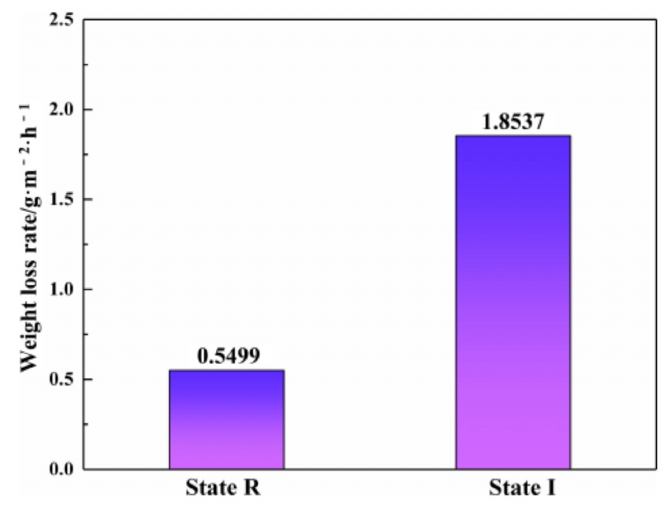
Figure 6. Weight losing rate of pitting corrosion in state R and state I. The negligible corrosion pits in state R are observed distributing spherically on the surface of samples (Figure 7a). As indicated by the red arrow in Figure 7c, the pits are open-type with an inner diameter less than the orifice diameter. Corrosion cracks emerge around the pits (yellow circle in Figure 7c), which indicates that the “bifurcation” expansion forms along a specific interface, for instance, grain boundaries or phase boundaries. In state I, the number of the corrosion pits increase (Figure 7d). There are evident peeling marks on the surface (Figure 7e). The morphologies of pits change from open-type to narrow-type, presenting a tiny outlet with a large cavity structure (Figure 7f). Corrosion develops to the inner areas of the sample, indicating that the dissolution rate inside the pits is greater than that of the surface. Similar to state R, a “bifurcation” corrosion gap still appears around the pits.